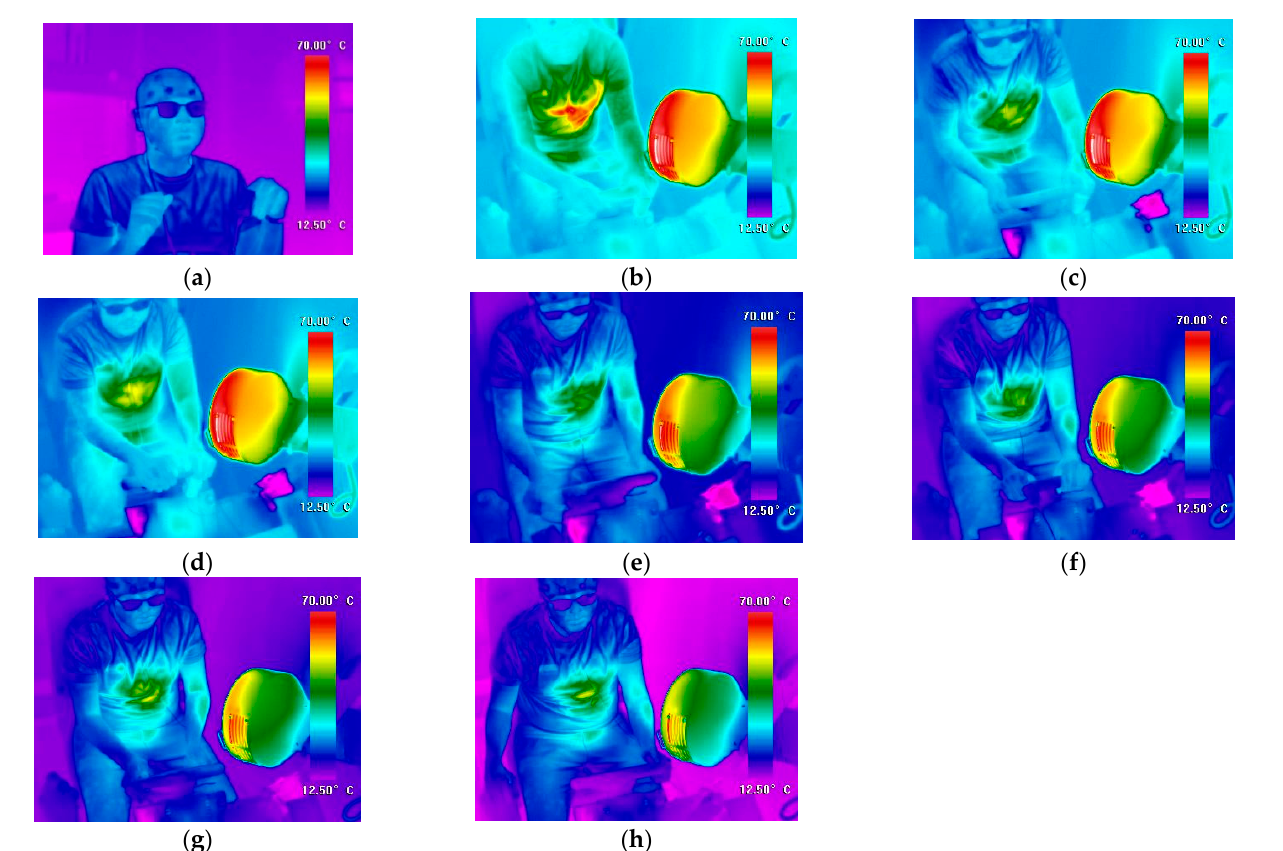
Figure 6. Photographs of driver’s thermal imaging in cooling mode. ( a ) Cabin 25 ◦ C/Non-Vent; ( b ) Cabin 35 ◦ C/Non-Vent; ( c ) Cabin 35 ◦ C/Vent 12.5 ◦ C; ( d ) Cabin 32.5 ◦ C/Vent 14.5 ◦ C; ( e ) Cabin 30 ◦ C/Vent 16.5 ◦ C; ( f ) Cabin 27.5 ◦ C/Vent 18.5 ◦ C; ( g ) Cabin 25 ◦ C/Vent 20.5 ◦ C; ( h ) Cabin 22.5 ◦ C/Vent 22.5 ◦ C.